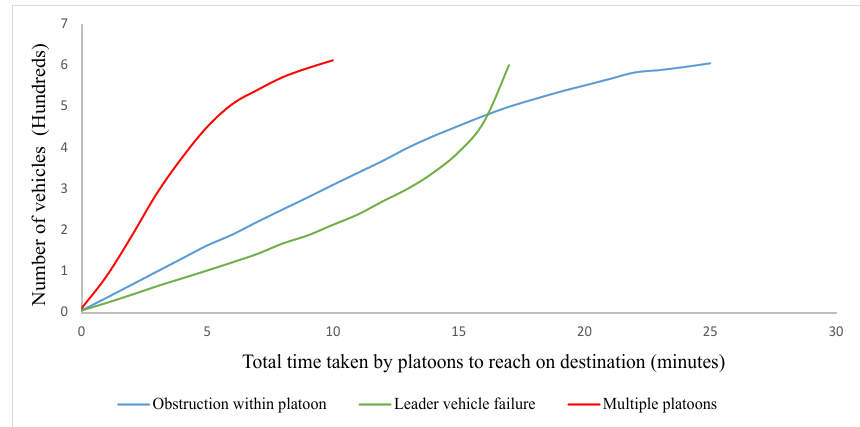
Figure 7. Comparison of different platooning